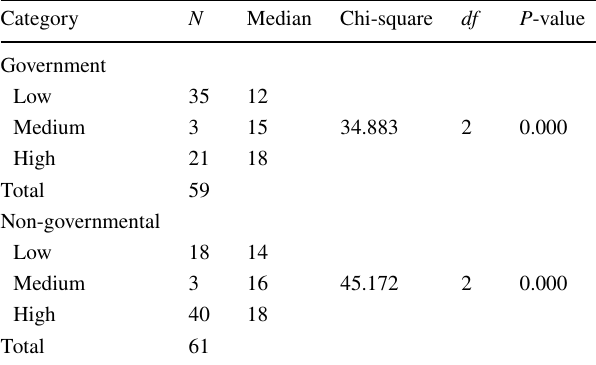
Table 9 Differences in effectiveness of PM&E on achievement of community-based water